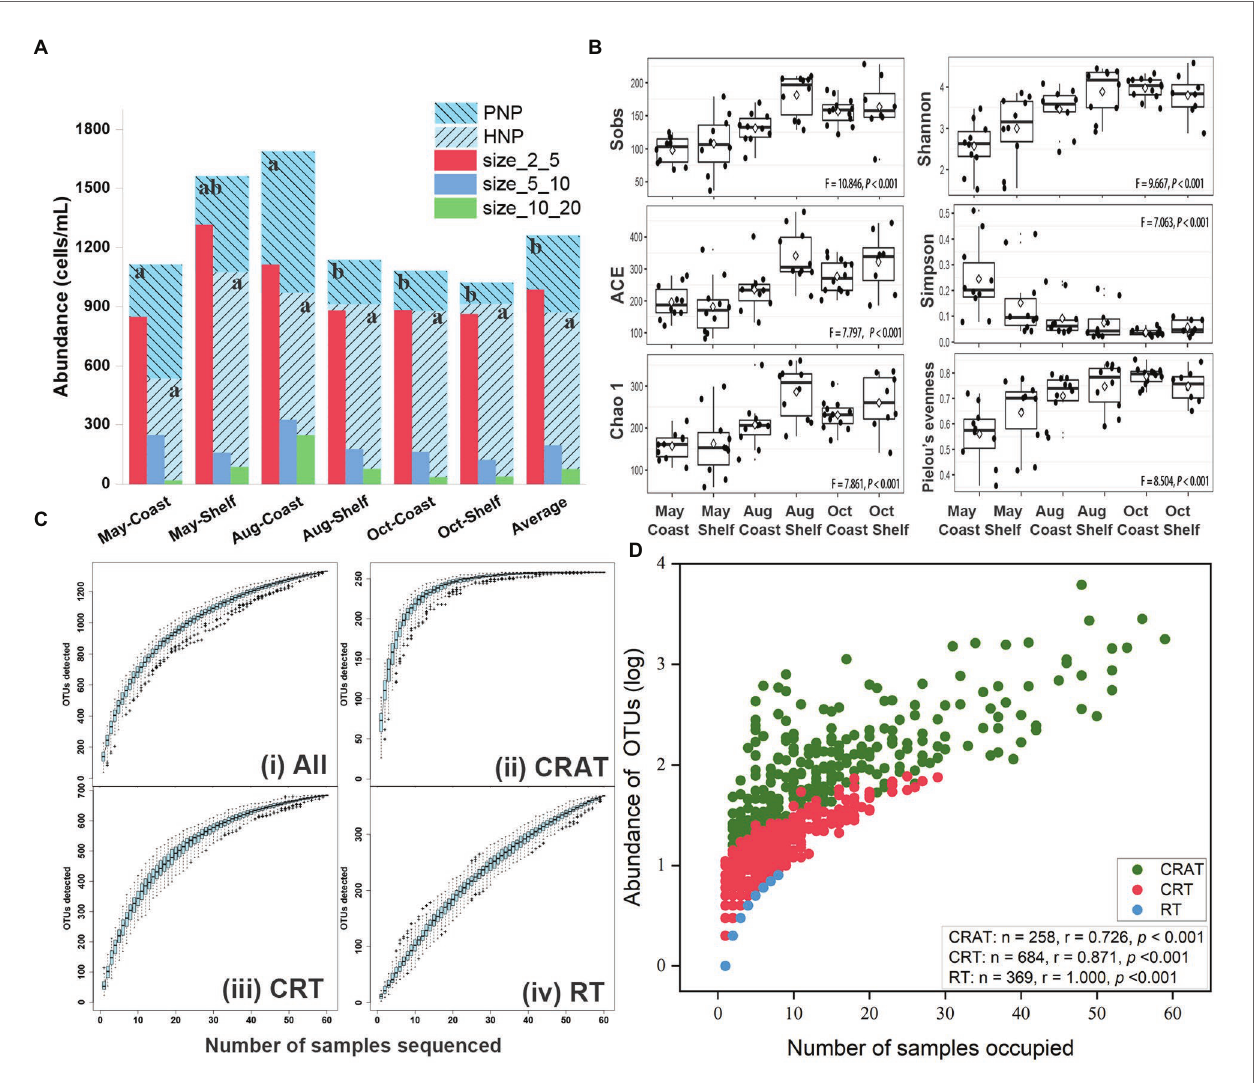
FIGURE 2 | Abundance, diversity, and abundance-occupancy relationships of protist community. (A) Cell abundance, trophic structure, and size structure of nano- sized protist communities across time and space. Different letters denote significant differences among groups. (B) Boxplots displayed the temporal and spatial distribution of alpha-diversity index of protist communities. Non-parametric test (Kruskal-Wallis ANOVA) was used to compare the differences among six groups and all values of p were lower than 0.001. The hollow diamonds represent average values of individual index in each group. (C) Species accumulation curves (SAC) of protist taxa [i. all OTUs; ii. conditionally rare and abundant taxa (CRAT); iii. conditionally rare taxa (CRT); and iv. rare taxa (RT)]. Boxplots in SAC showed the range of OTU richness for each number of samples sequenced. (D) Abundance-occupancy relationships between OTU richness and number of sites occupied. Spearman’s rank correlations were used to evaluate the relationships between abundance of OTUs (log-transformed) from three different microbial subcommunities and the number of sites occupied ( n is the number of